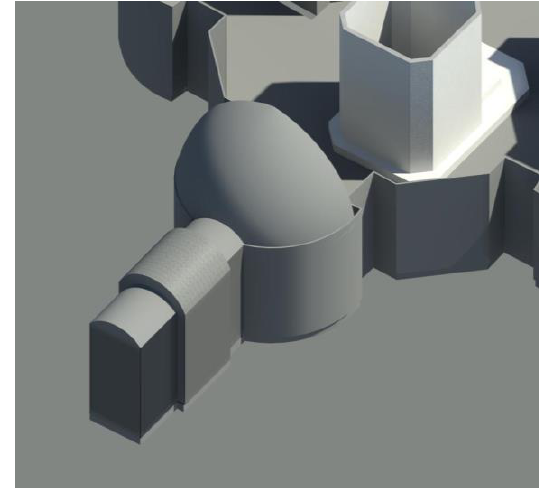
Figure 22. Parametric libraries for vault in first